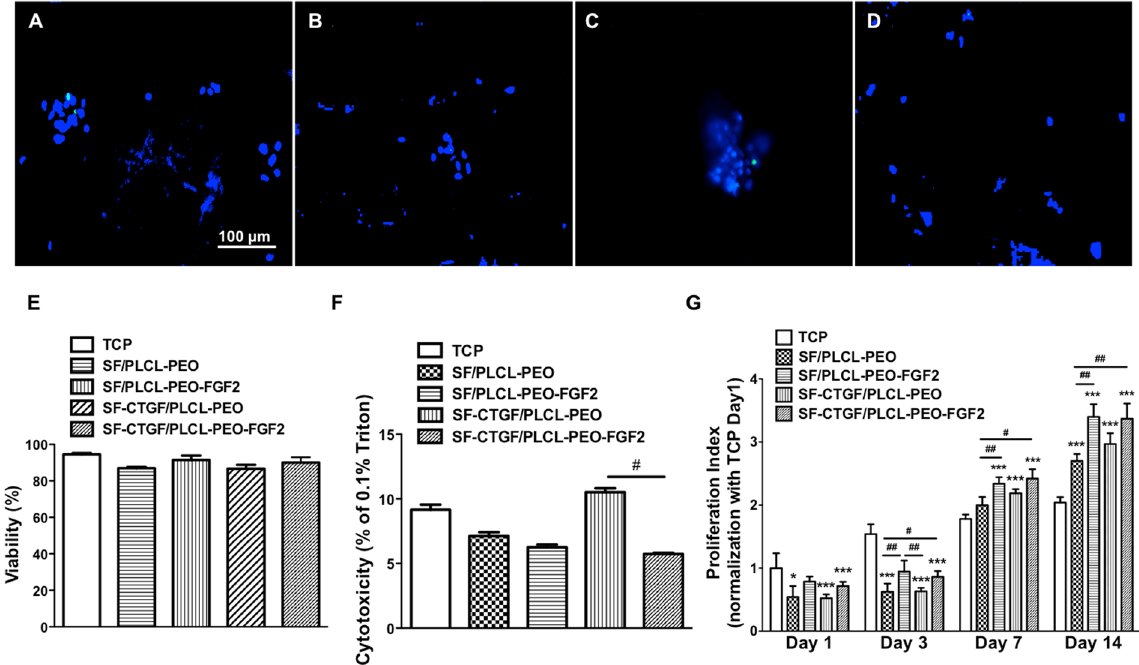
Figure 4. Analysis of biocompatibility of different coaxial scaffolds. ( A – D ) Representative images of live- dead staining of rMSCs after 1 day culture on different scaffolds SF/PLCL-PEO ( A ), SF/PLCLPEO-FGF2 ( B ), SF-CTGF/PLCL-PEO ( C ) and SF-CTGF/PLCL-PEO-FGF2 ( D ). All cells were counterstained with NucBlue live reagent, nuclei of dead cells were counterstained with NucGreen dead reagent. ( E ) The quantified data from ( A – D ), at least 200 cells were counted for each group. ( F ) Analysis of cytotoxicity of different scaffolds to rMSCs after 1 day culture by LDH assay. ( G ) Analysis of rMSCs proliferation on different scaffolds after a 14- day incubation by CCK assay. (One-way repeated-measure Analysis of Variance test (ANOVA) were used to compare multiple groups. * and *** stand for significant difference between samples on scaffolds and samples on tisue culture plastic (TCP) at same time point with p < 0.05 and p < 0.001, respectively; # and ## stand for significant difference among different scaffolds at same time point with p < 0.05 and p < 0.01,